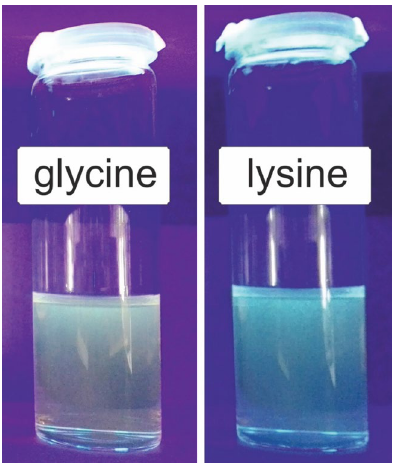
Figure 13. Solutions after preparation with the precursors glycine or lysine under illumination with a UV lamp. The process tempera- ture is 140 °C and the process duration is 15 minutes.